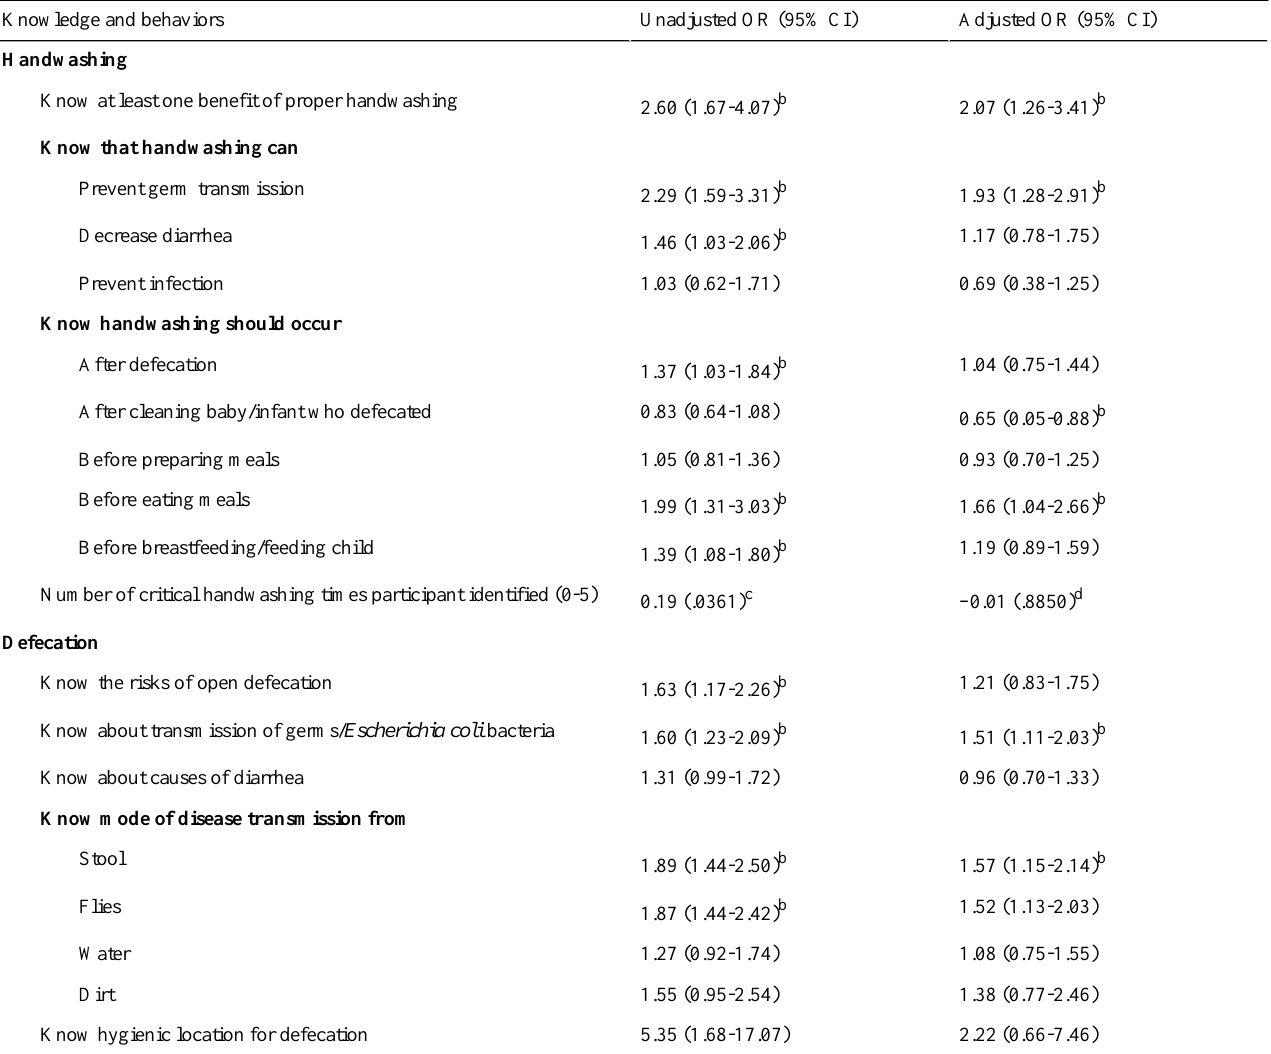
Table 3. Use of technology to access health services and its impact on knowledge of hygiene and defecation in Banyuasin, Kubu Raya, and Katingan in 2018.